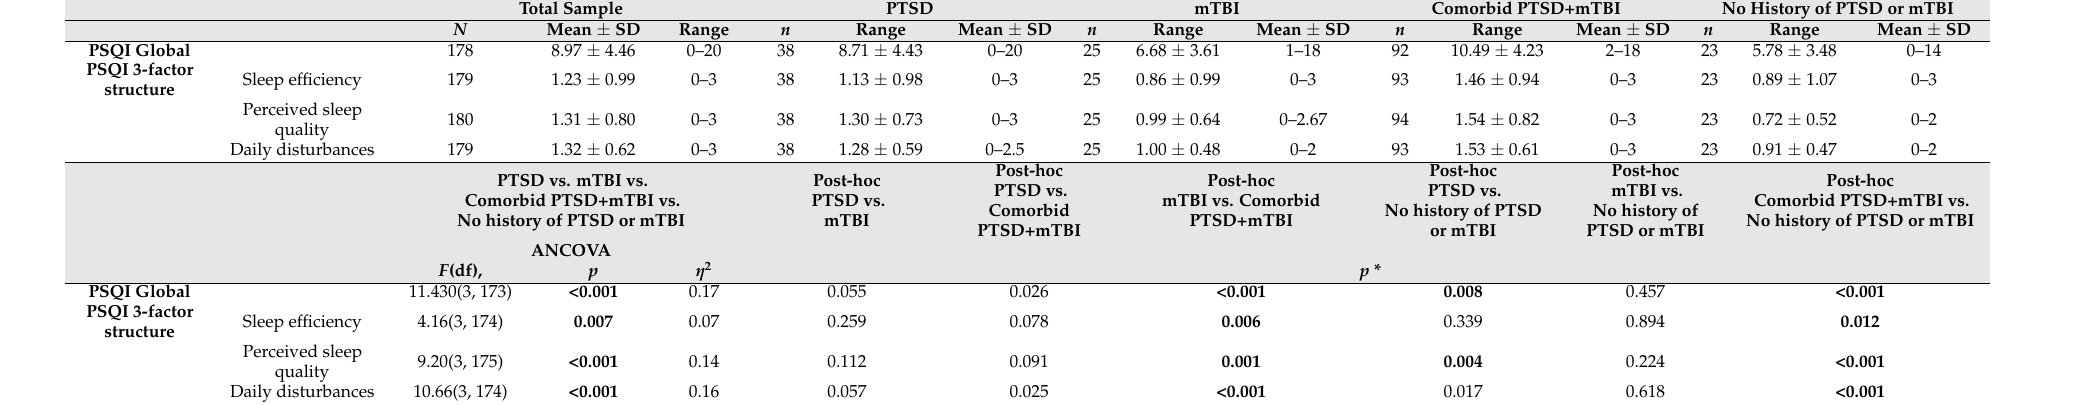
Table 2. Sleep quality group